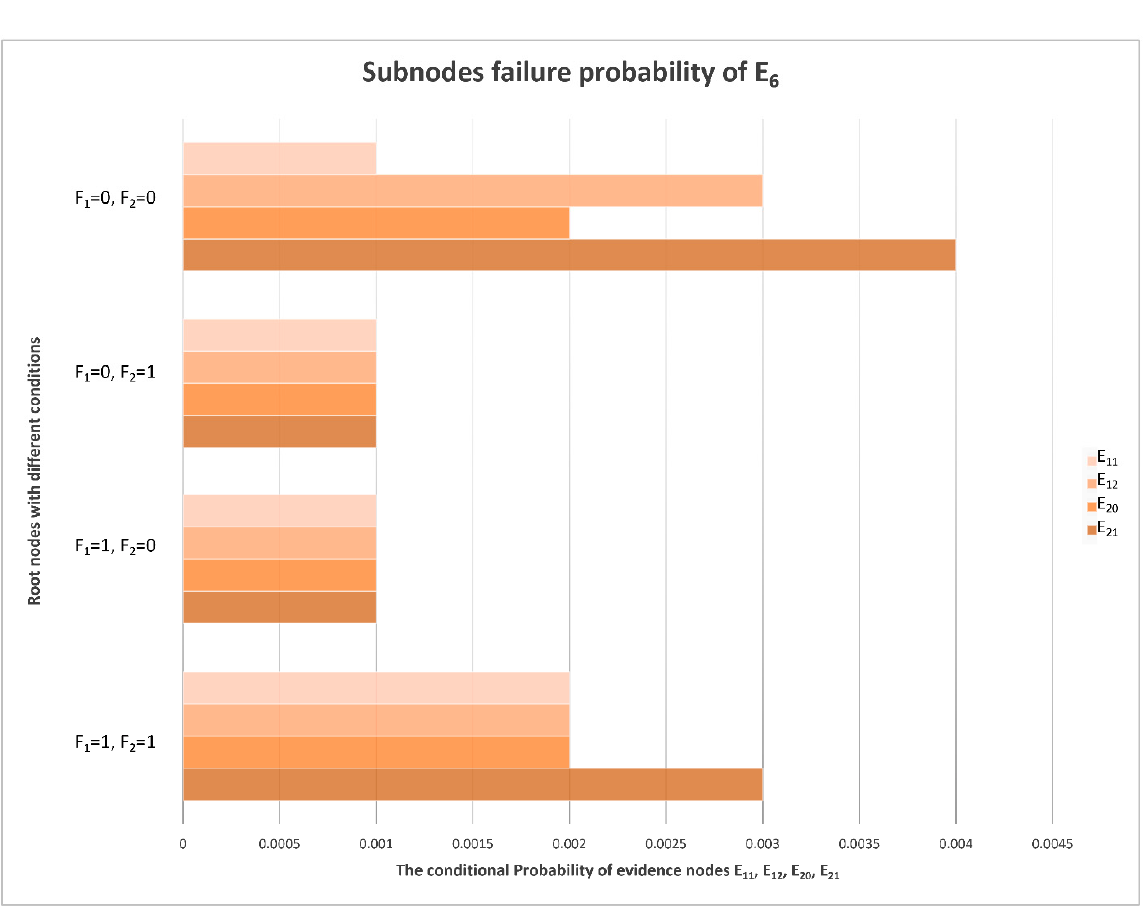
Figure 11. Conditional probability distribution diagram of E 6 ’s sub-nodes.